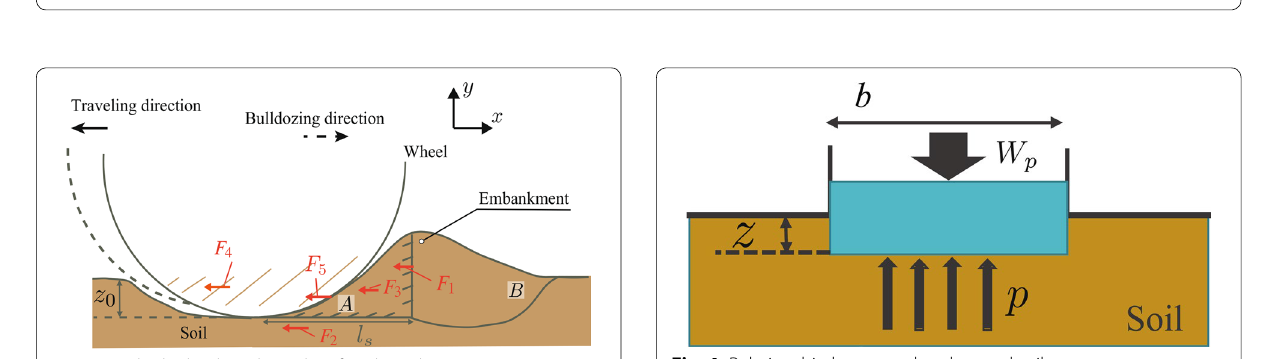
Fig. 3 Locked-wheel on the soil surface based on Wong’s observation [9]. The soil wedge (area A ) beneath the wheel is assumed to move together with the wheel. The surface between soil wedge areas A and B is assumed as a virtual surface